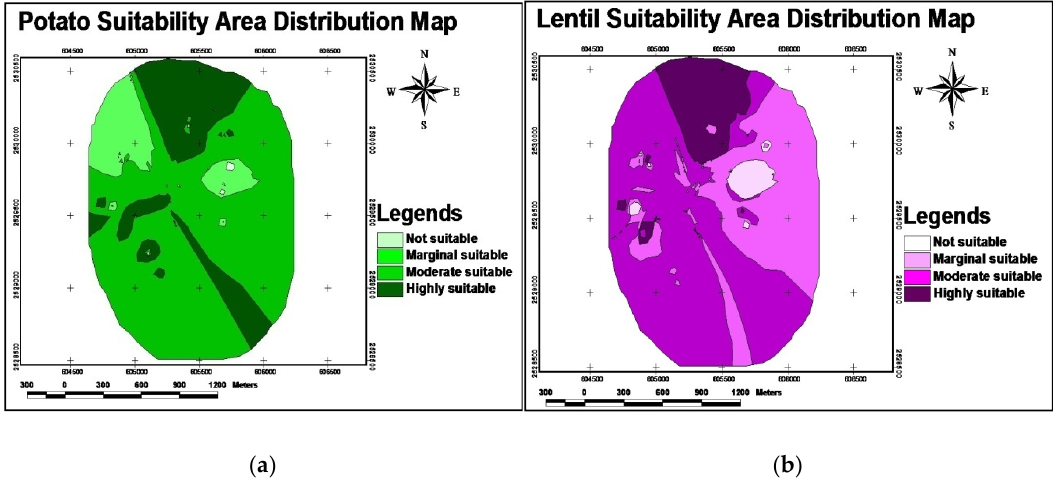
Figure 5. Rabi season crops suitability distribution maps; ( a ) potato, ( b ) lentil.